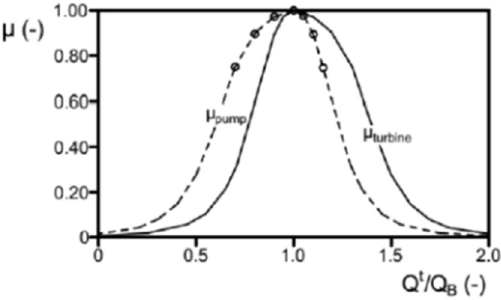
Figure 2. Standard reliability curves, pump and turbine modes [24].